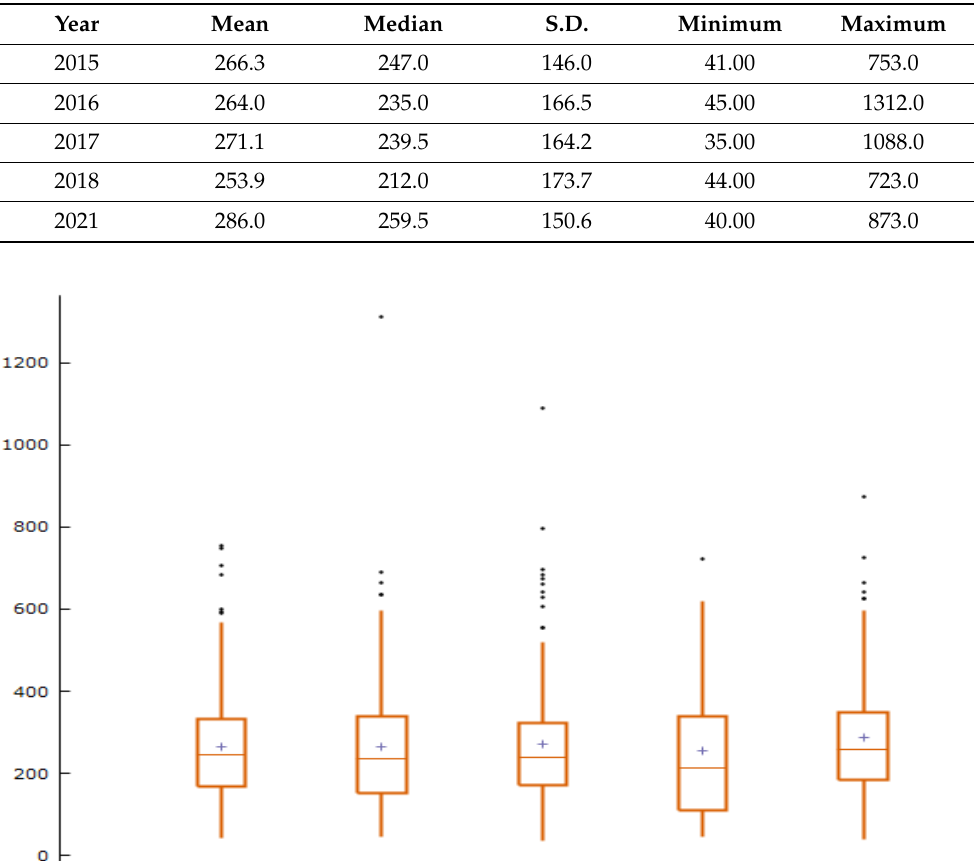
Table 1. Summary statistics of the frequency of visitors of TFE Masaryk Forest Kˇrtiny (Forest Road “ ˇCerven á ”) in the subsequent years.